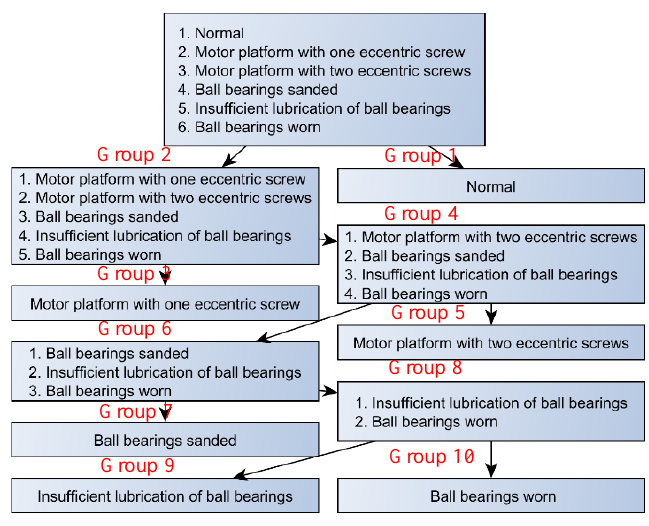
Figure 11. Binary tree: inspection and classification.